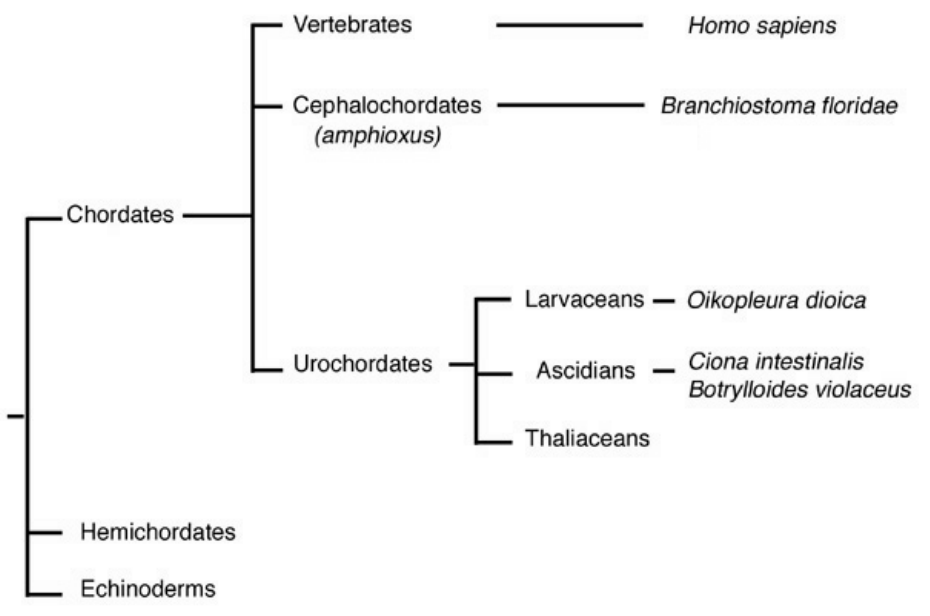
FIGURE 1 . Phylogenetic tree of the different phyla of the Deuterostomia. The chordate phylum is divided into three subphyla: urochordates, cephalochordates, and vertebrates. Examples of species relevant for this review are listed on the